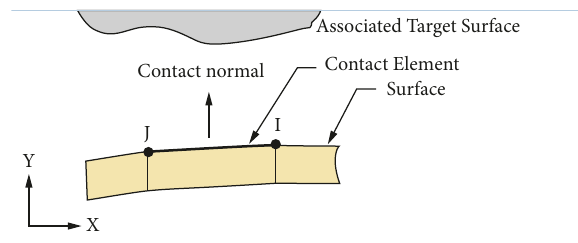
Figure 16: CONTA171 geometry (ANSYS